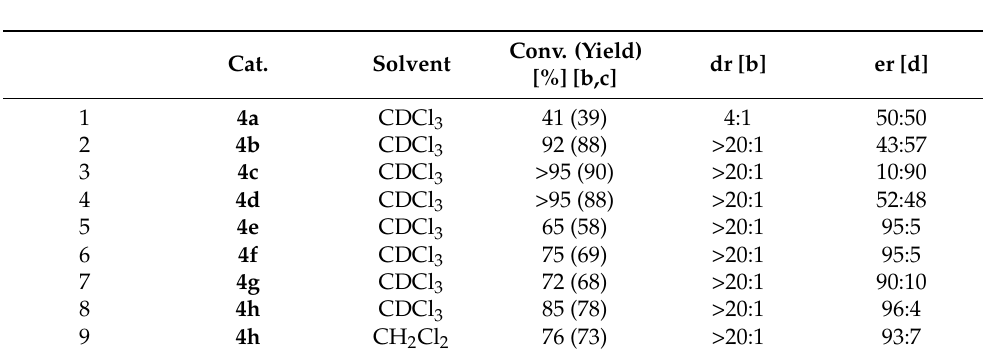
Table 1. Asymmetric dearomative (3+2)-cycloaddition between nitro-substituted benzoheteroarenes 1 and N -2,2,2-trifluoroethyl-substituted isatin imines 2 –optimalization studies [a].